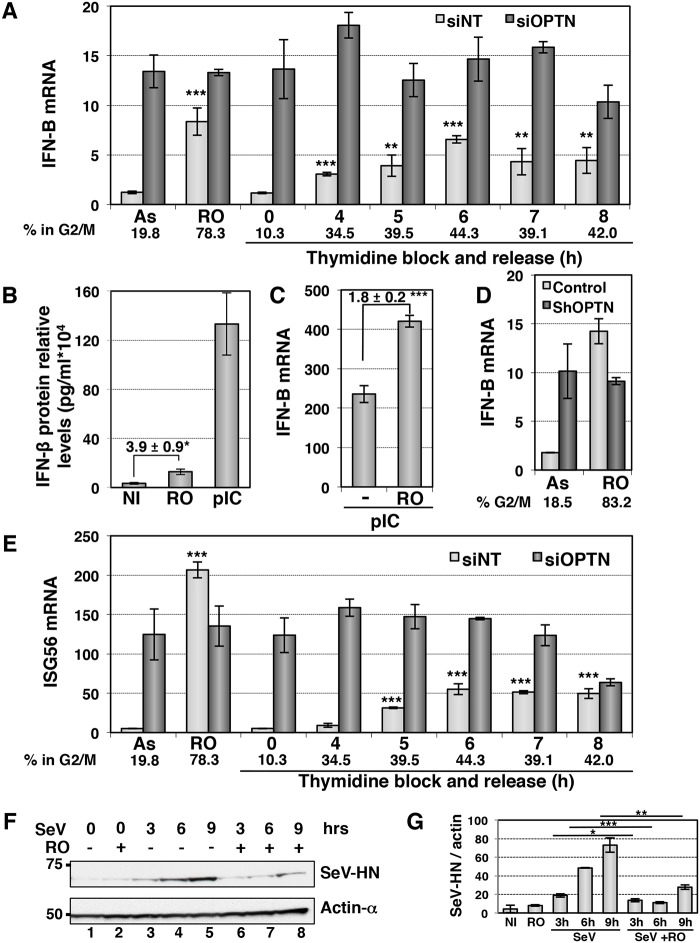
The IFN/ISG signaling pathway is induced in G2/M synchronized cells.(A) IFN-B mRNA levels were determined by RT-QPCR as described in Fig 1E, in HeLa cells transfected with non-target siRNAs (white bars) or with Optn-specific siRNAs (dark bars) and left unsynchronized (AS), blocked in G2/M phases by RO-336 treatment (RO) or blocked in G1/S transition by double thymidine block and release for the time indicated (in hours). Mean ± SD values of expression levels are presented. Paired t-test was used to determine the significance of the IFN-B level difference between asynchronous and synchronized cells. ** p values < 0.01, *** p values < 0.001. Average % of cells in G2/M determined by PI staining/FACS analysis for both siNT- and siOptn-transfected cells is shown. (B) IFN-β protein levels were determined by ELISA in the supernatants of HeLa cells left untreated (NI), synchronized in G2/M by RO-3306 (RO) or stimulated by poly(I:C) (pIC). Mean ± SD values of expression levels relative to 104 cells are presented. Mean ± SD values of the induction folds corresponding to the ratio of the IFN-β protein level observed in RO-treated cells to that observed in control cells, is shown. * p values < 0.05. (C) IFN-B mRNA levels were determined by RT-QPCR in HeLa cells transfected with poly(I):(C) (pIC) and left unsynchronized (-), blocked in G2/M phases by RO-336 treatment (RO) as described in (A). Mean ± SD values of the induction folds corresponding to the ratio of the IFN-B expression level observed in RO-treated cells to that observed in control cells, is shown. *** p values < 0.001. (D) IFN-B mRNA levels were determined by RT-QPCR as described in (A) in control or stably Optn deficient HeLa cells transfected left unsynchronized (AS) or blocked in G2/M phases by RO-336 treatment (RO). The % of cells in G2/M determined in each condition by PI staining/FACS analysis is shown. (E) ISG56 mRNA levels were determined by RT-QPCR as described in (A), in HeLa cells transfected with non-target siRNAs or with Optn-specific siRNAs and left unsynchronized (AS), blocked in G2/M phases by RO-336 treatment (RO) or blocked in G1/S transition by double thymidine block and release for the time indicated (in hours). Mean ± SD values of expression levels, significance and average % of cells in G2/M are calculated as in (A). (F) Western blot analyses of extracts from asynchronous and RO-treated cells before and after different time (in hours) of SeV-infection using Hemagglutinin-Neuraminidase Protein of the Sendai virus (SeV-HN) and anti-actin-α antibodies. (G) Quantification of the signals obtained in (F) is presented as a ratio of SeV-HN protein levels versus actin levels. Paired t-test was used to determine the significance of the difference between the SeV-HN protein levels observed in asynchronous versus G2/M-treated cells after infection. * p values < 0.05, ** p values < 0.01, *** p values < 0.001.